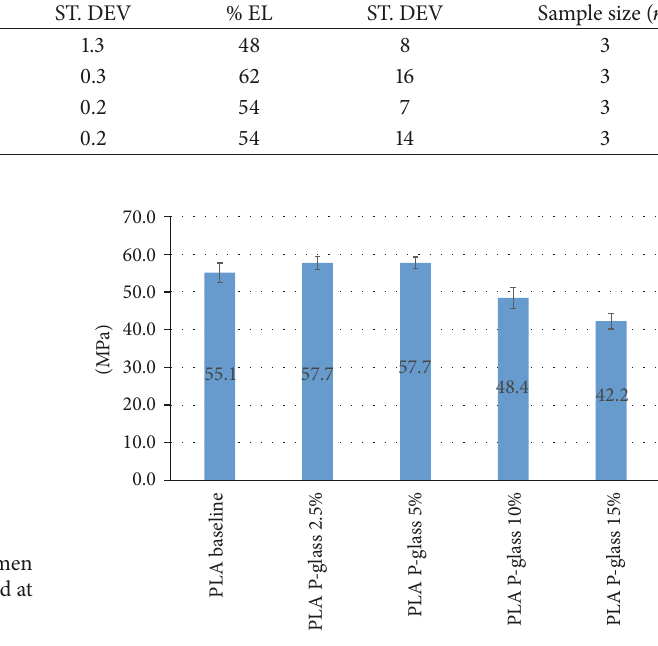
Figure 15: UTS values for PLA loaded with P-glass at various weight